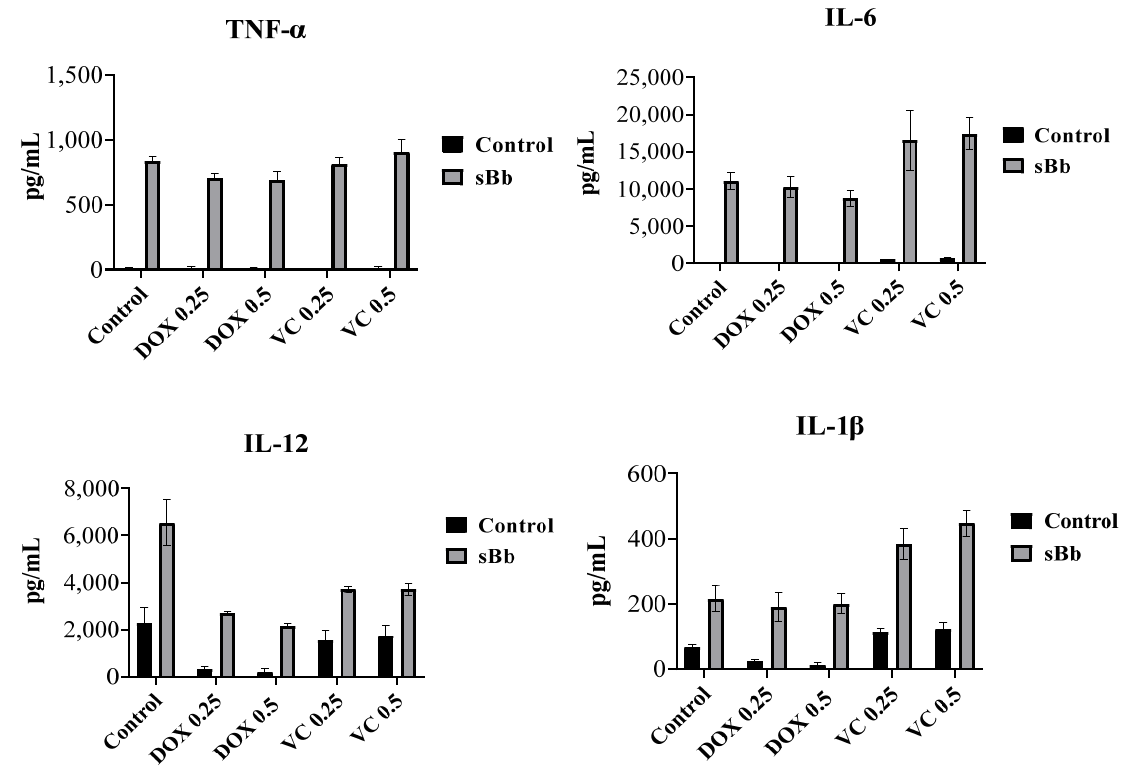
Figure 6. sBb increases the cytokine production of DCs. The supernatants of DOX, VC, and/or sBb treated DCs were harvested and used for ELISA. The amount of TNF- α , IL-1 β , IL-6, and IL-12 produced by the treated DCs were measured by ELISA kits according to the manufacturer’s instruc- tions.